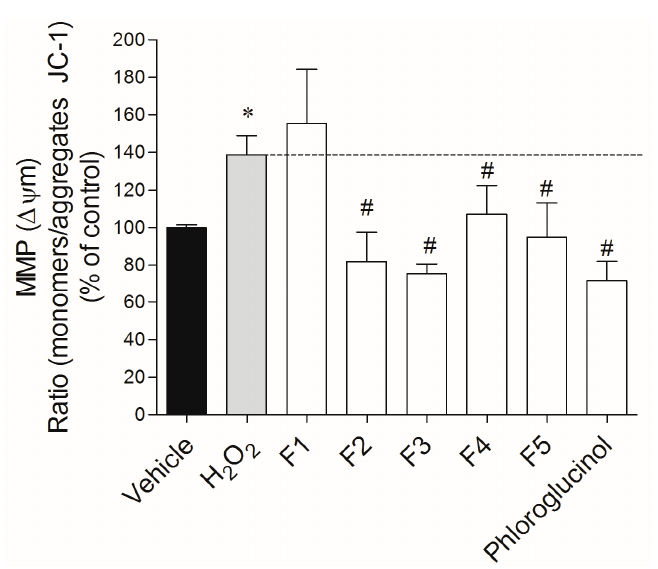
Figure 4. H 2 O 2 (0.2 mM) effects on the mitochondrial membrane potential (MMP) of MCF-7 cells in the absence or presence of Fucus spiralis fractions (1 mg/mL) after 24 h of treatment. The results were obtained by the ratio between the monomers/aggregates of JC-1. The values in each column represent the mean ± standard error of the mean (SEM) of seven or eight independent experiments. Symbols represent statistically significant differences ( p < 0.05, ANOVA, Dunett’s test) when compared to: * vehicle and # to H 2 O 2 .